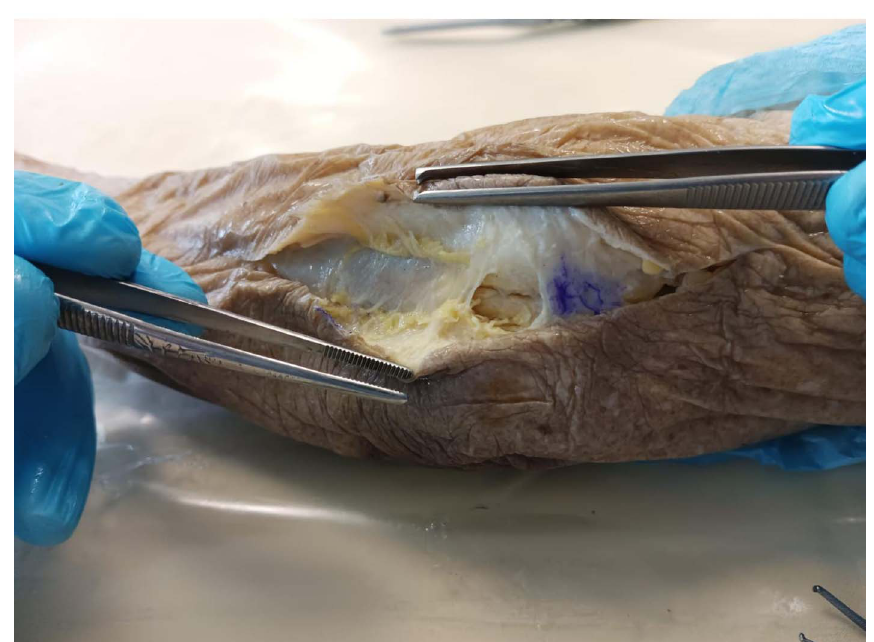
Figure 5. Sites of ulnar nerve